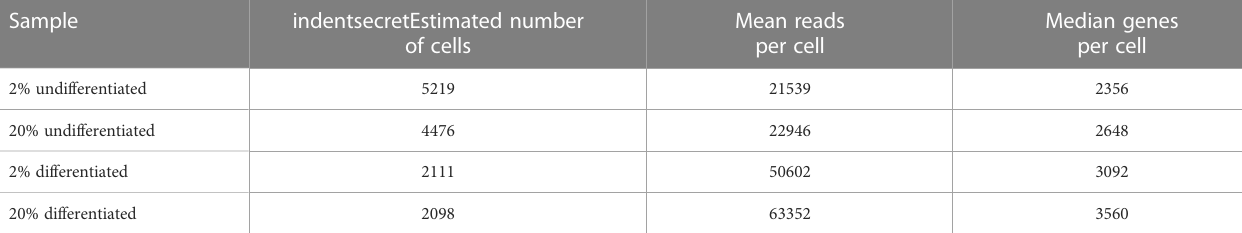
TABLE 2 Single-Cell RNA-sequencing.